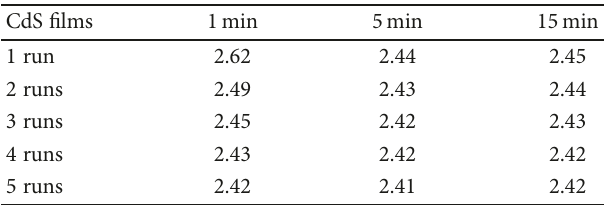
Table 4: The band gap values in eV of the prepared CdS thin fi lms as a function of the number of runs and deposition time.